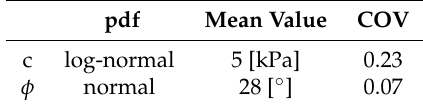
Table 2. Stochastic properties for in situ soil cover.